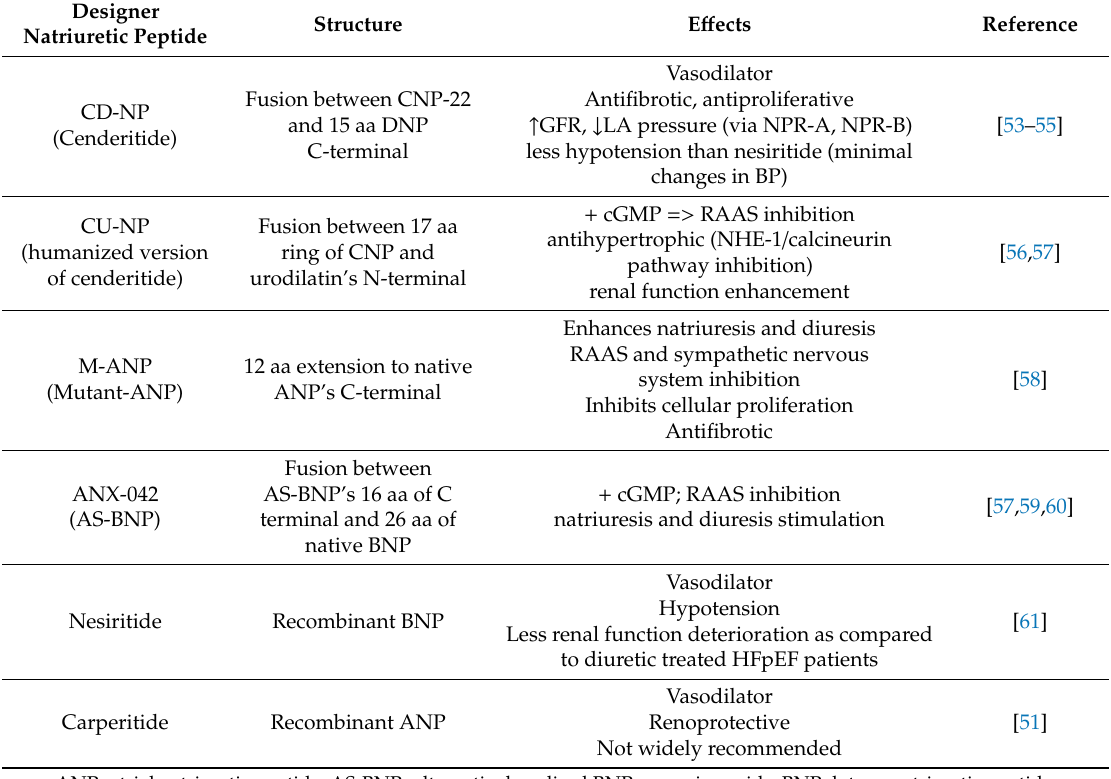
Table 3. Designer natriuretic peptides as potential therapies in heart failure.